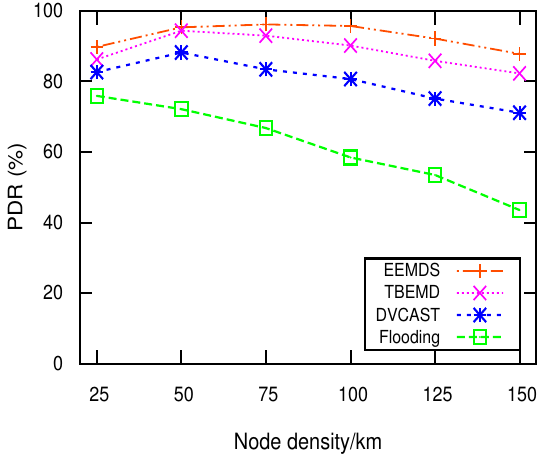
Figure 5. PDR vs. node density.